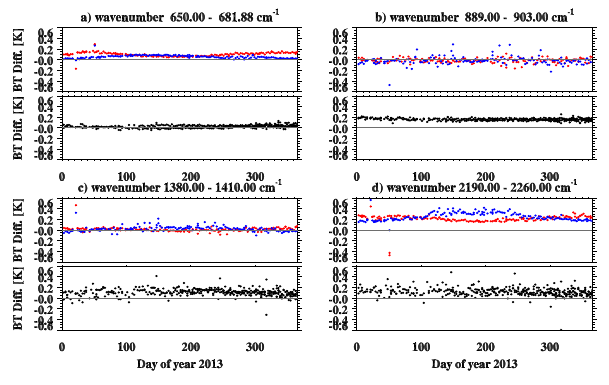
Figure 15. Time series of CrIS–AIRS BT differences at four spec- tral regions: (a) 650–681.88cm − 1 , (b) 889–903cm − 1 , (c) 1380.0– 1410.00cm − 1 , and (d) 2190–2260cm − 1 . The red, blue, and black dots indicate the BT differences from north SNOs, south SNOs, and tropical